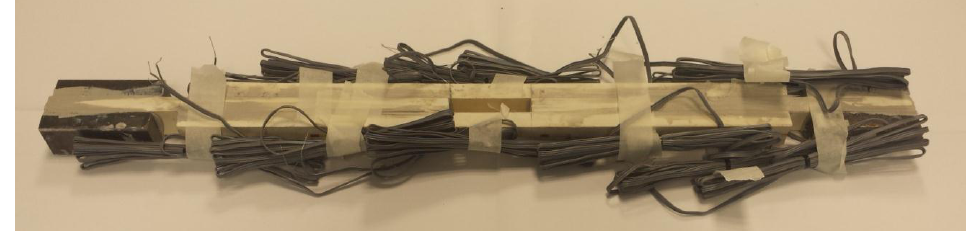
Figure 7. Joint sample “I” (after strain gauges application).